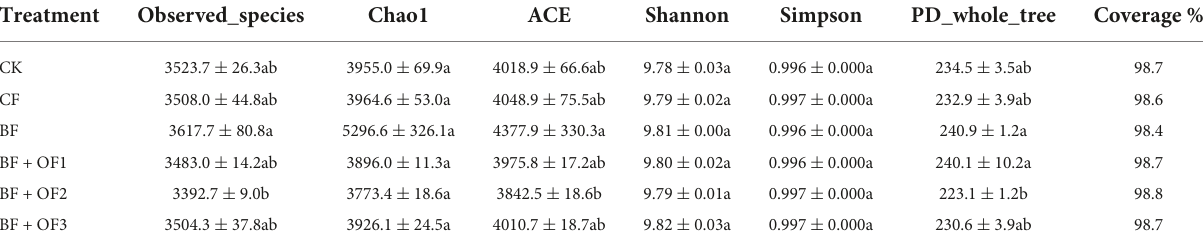
TABLE 4 Species number and bacterial diversity index under different